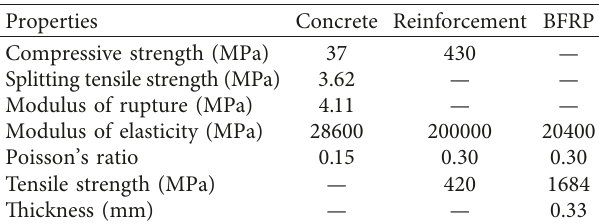
Table 2: Mechanical properties of the composite